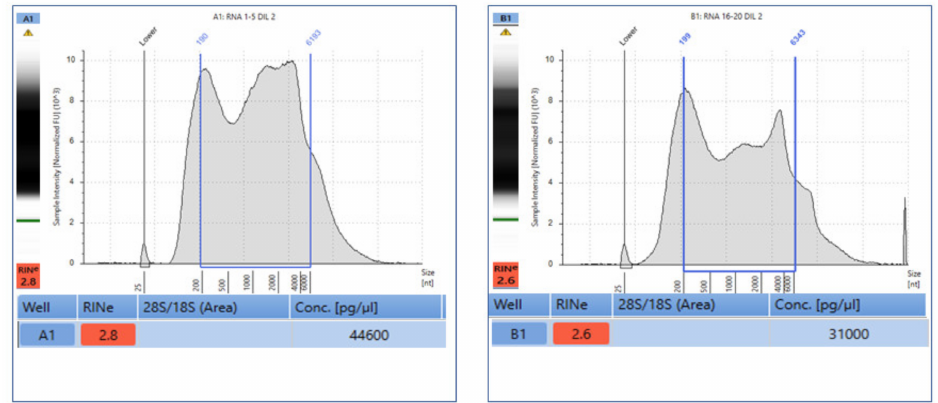
Figure 2. Schematic representation of RNA quantification and qualification from two representative slide sets of FFPE reference standard sample developed by Seracare Life Sciences on Tape Station 4200 (Agilent) platform.